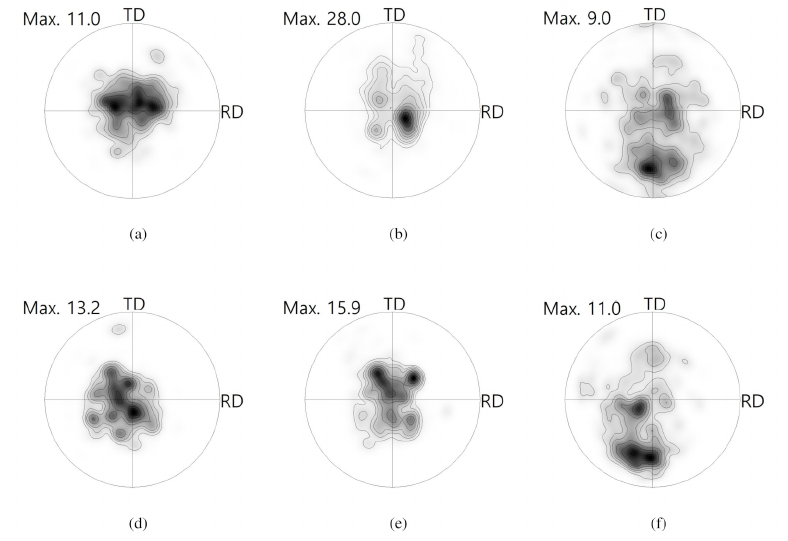
Figure 11. 0001 PFs computed from EBSD maps, as shown in Figure 10. Contours: 1, 2, 3, 5, 7, 10, 15, 20. ( a ) Part 1, ( b ) Part 2, and ( c ) Part 3 for TRC sheets. ( d ) Part 1, ( e ) Part 2, and ( f ) Part 3 for IC